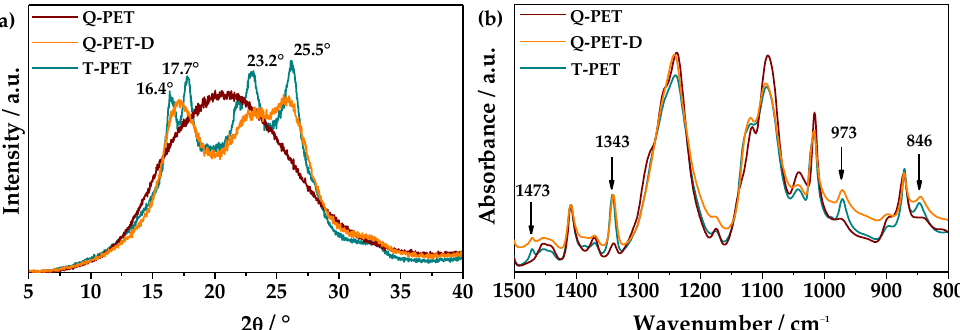
Figure 3. X-ray Diffraction data ( a ) and FTIR spectra ( b ) of T-PET and Q-PET samples before and after (D) the solvent treatment. SEM micrographs of the Q-PET-D surface after immersion in DCM are included in Figure 4.